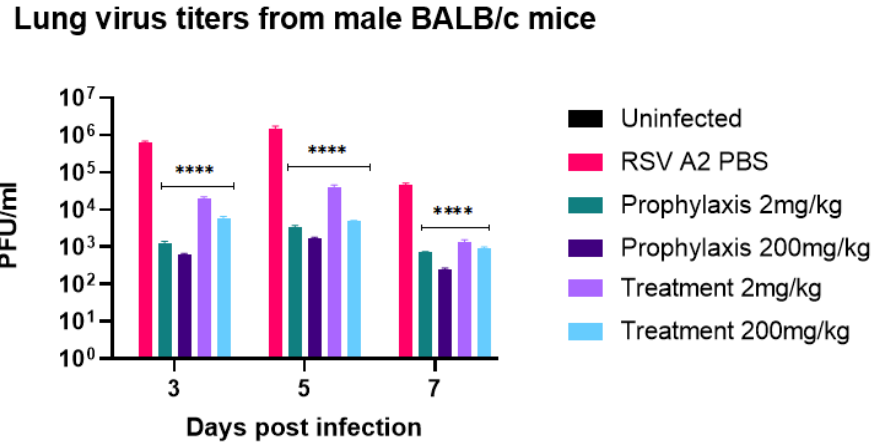
Figure 3. Lung virus titers from male BALB/c mice. The mice received 2 mg/kg or 200 mg/kg probenecid 24 h before infection (prophylaxis) or 24 h pi (treatment). The mice were i.n. infected with 10 6 PFU of RSV A2. On days 3, 5, and 7 pi, the lungs were harvested, and virus titers were determined by plaque assay having a limit of detection of 1 × 10 2 PFU/mL. There is significant (**** p < 0.0001) reduction in lung viral titers with all probenecid treatments compared to control (PBS).